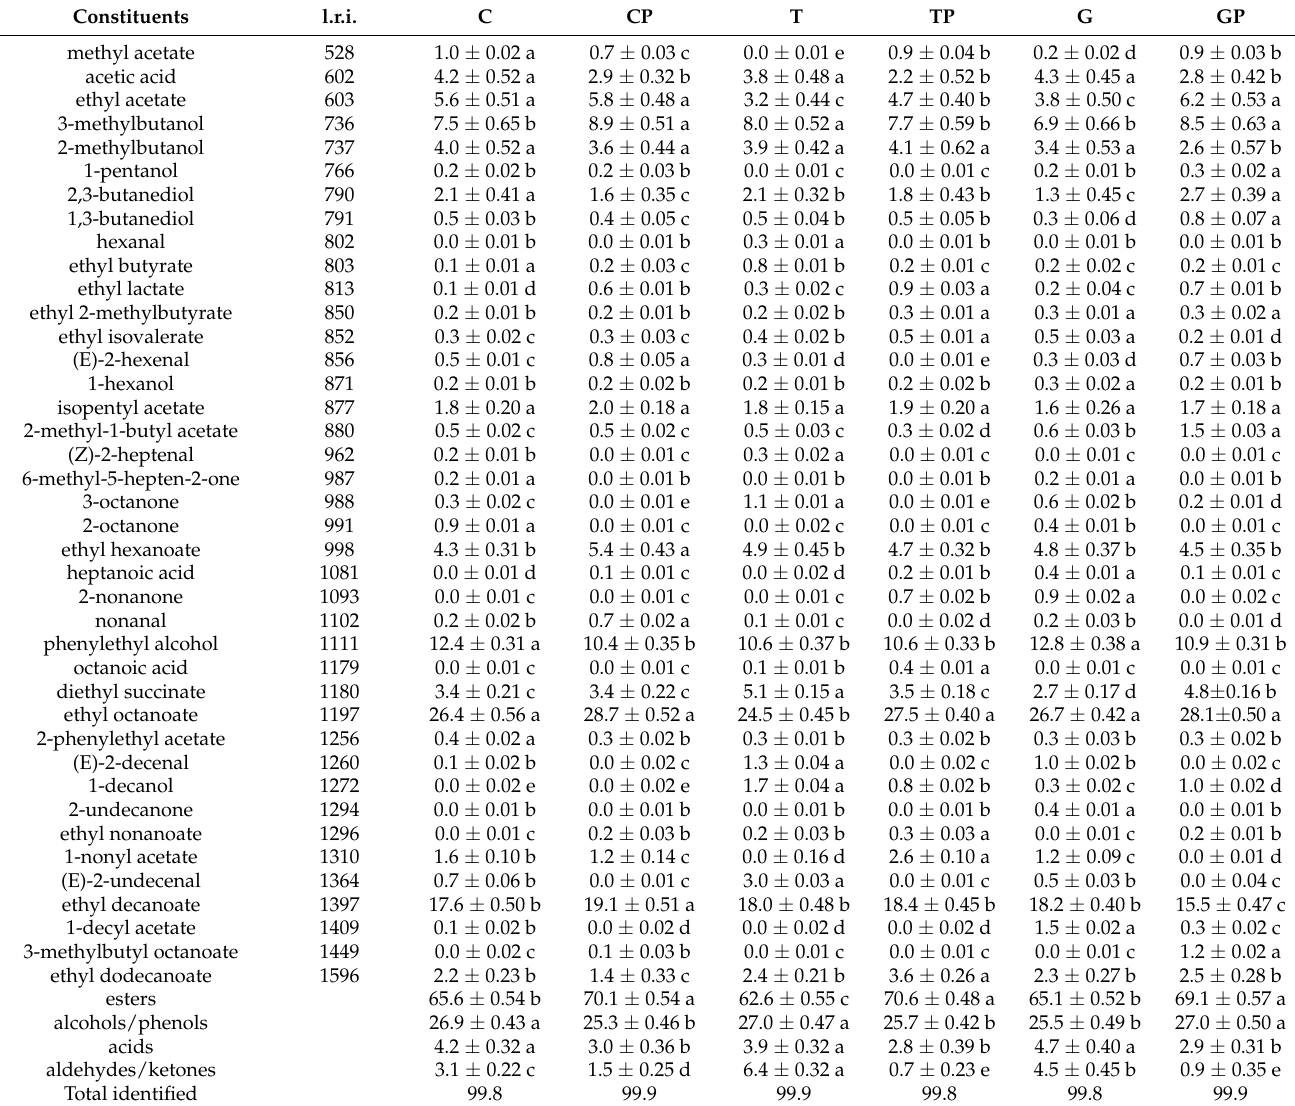
Table 11. Main classes of volatile compounds detected in the wines tested at the end of aging and relative percentage